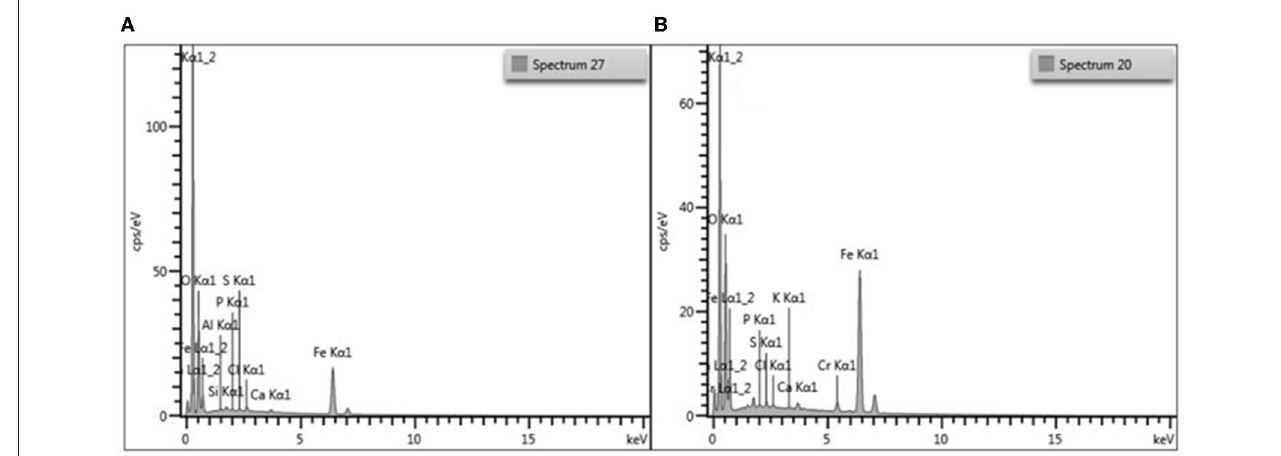
FIGURE 2 | EDS spectrum of (A) Fe 3 O 4 (B) Fe 3 O 4 /FMO.